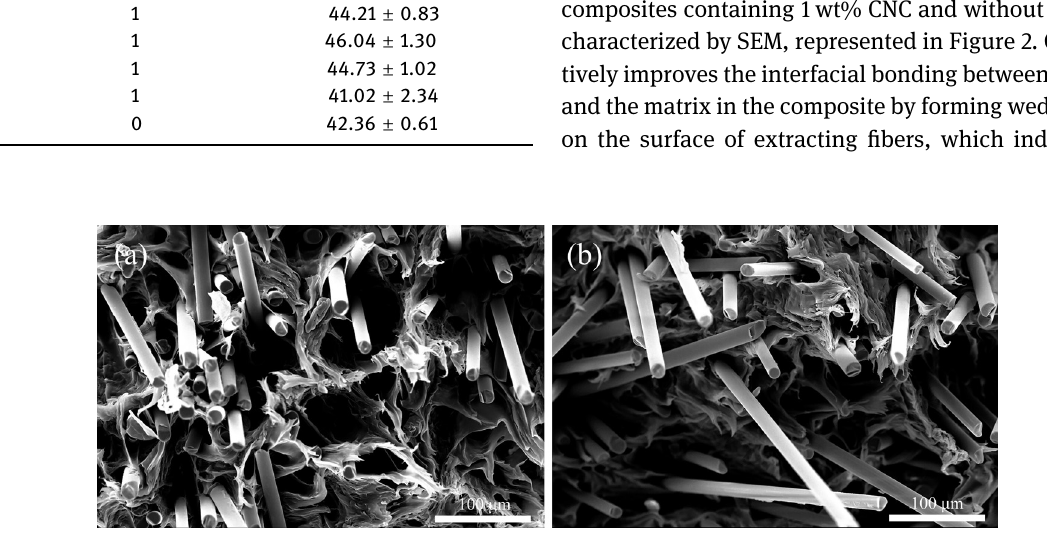
Figure 2: SEM images of tensile cross - sections of composites with and without CNCs when the BF content is 30 wt%: ( a ) 30 wt% BFs and ( b ) 30 wt% BFs/1 wt%